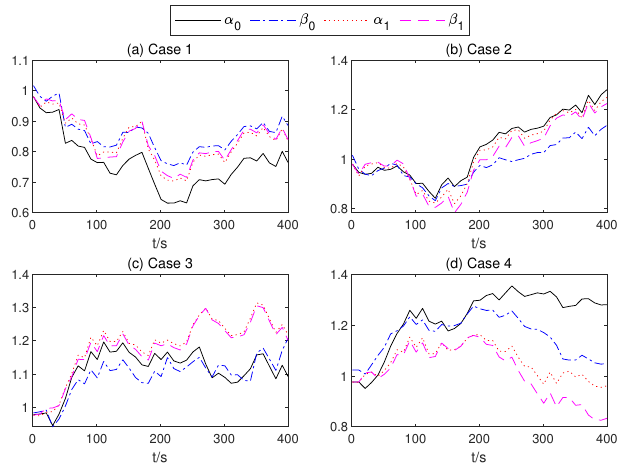
Figure 13. θ 1 of the mean part of the TSMC